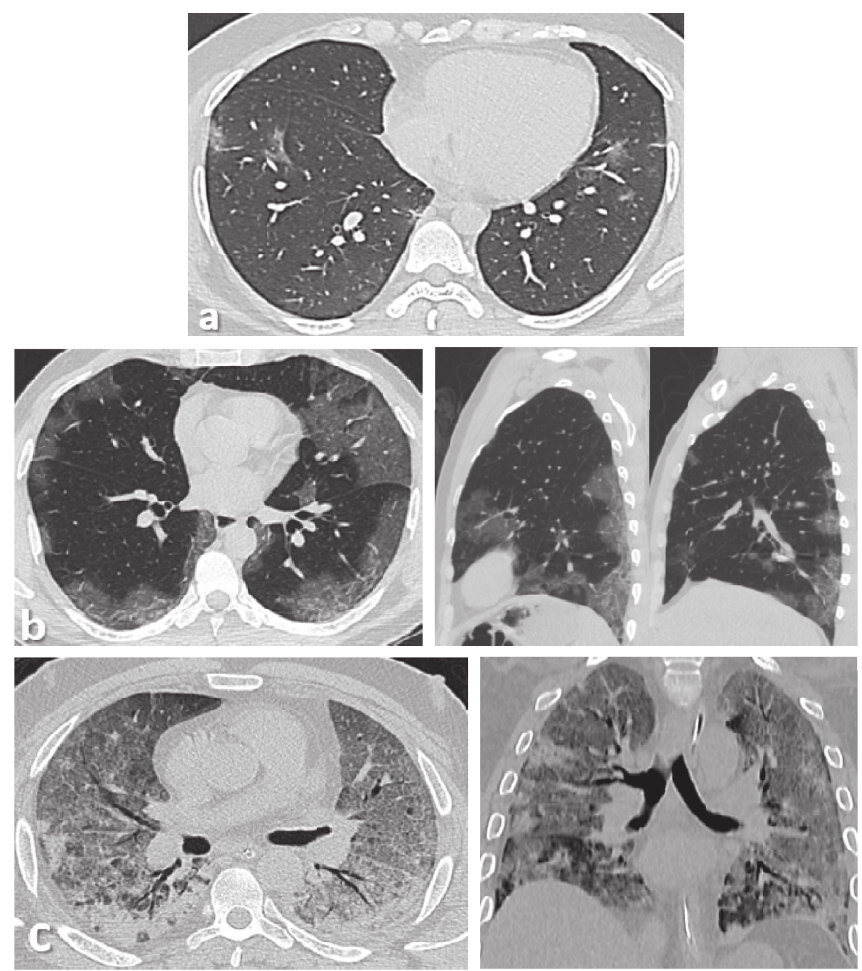
Figure 1: (a) Axial thin sections of unenhanced CT chest scan show mild GGO involving bilateral peripheral lower lobes. (b) Axial and sagittal sections show bilateral peripheral multilobe GGO of moderate disease severity. (c) Axial and coronal sections show diffuse crazy- paving pattern with areas of peripheral consolidations indicating severe